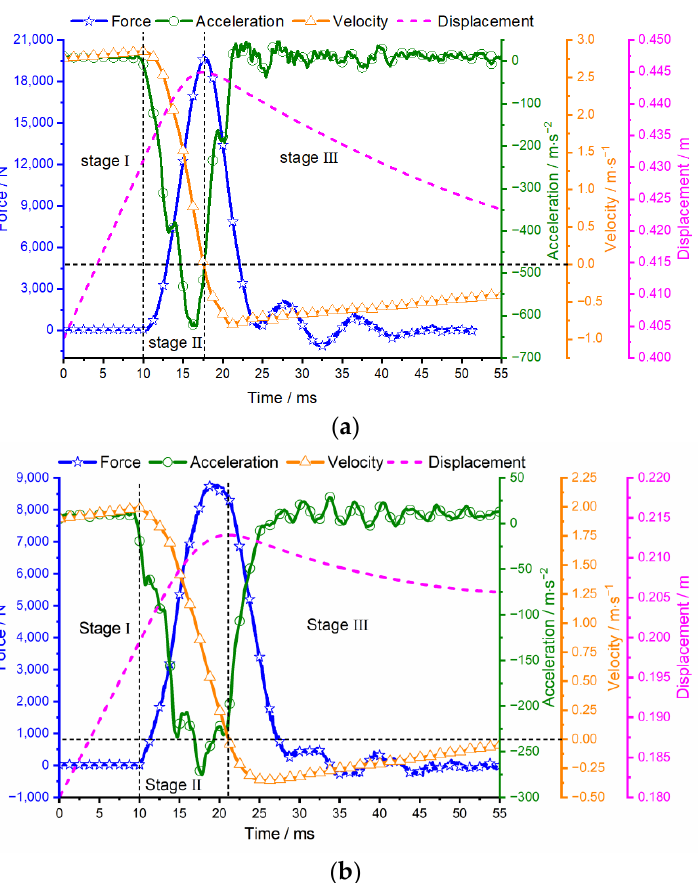
Figure 5. Drop-weight test results of the battery along Z+ vectors. ( a ) Test results for Z1+ orientation; ( b ) Test results for Z2+ orientation.